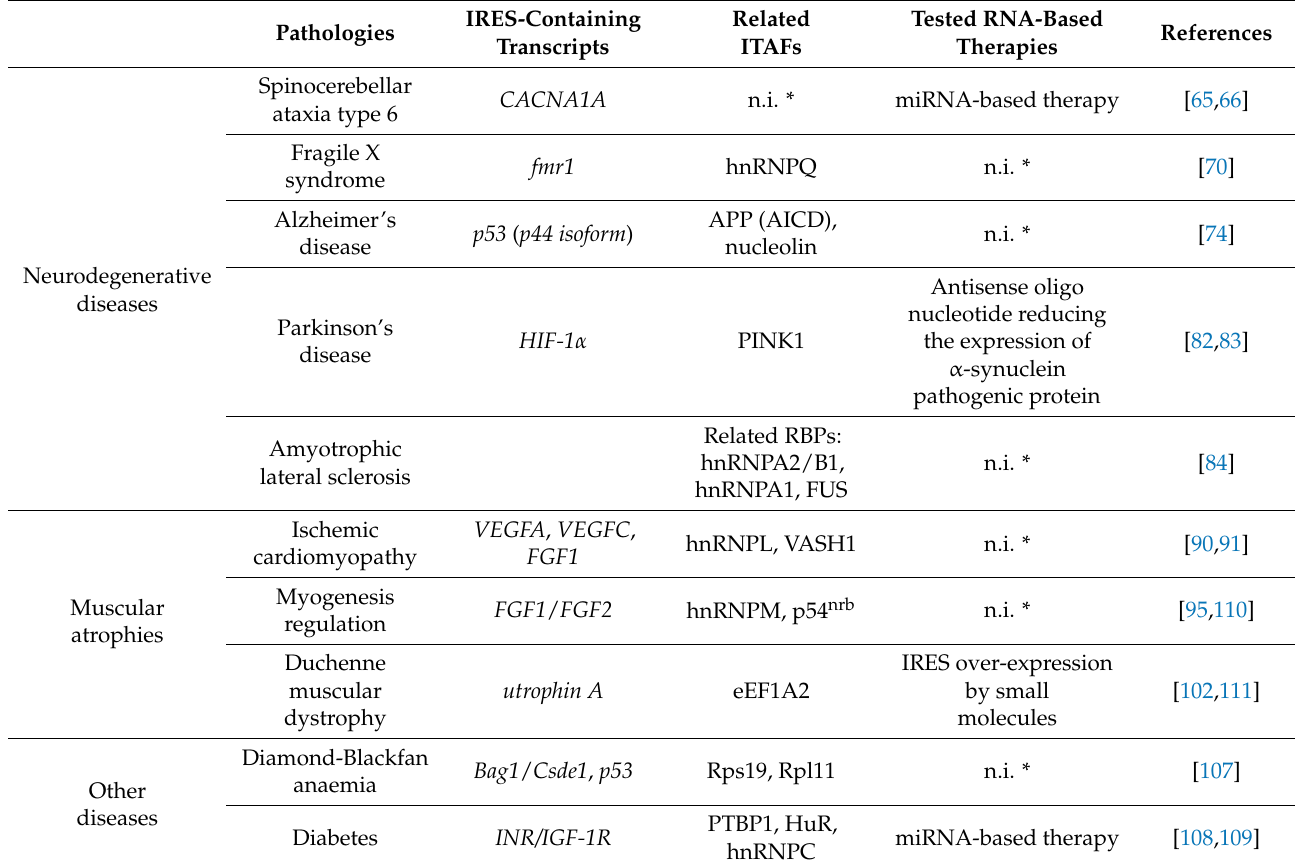
Table 1. Summary of different groups of diseases, other than cancer, caused by IRES-mediated translation initiation misregulation. Here are listed the internal ribosome entry sites (IRESs) and IRES trans -acting factors (ITAFs) correlated to each pathology. The existing IRES-related RNA-based therapies for each pathology are also